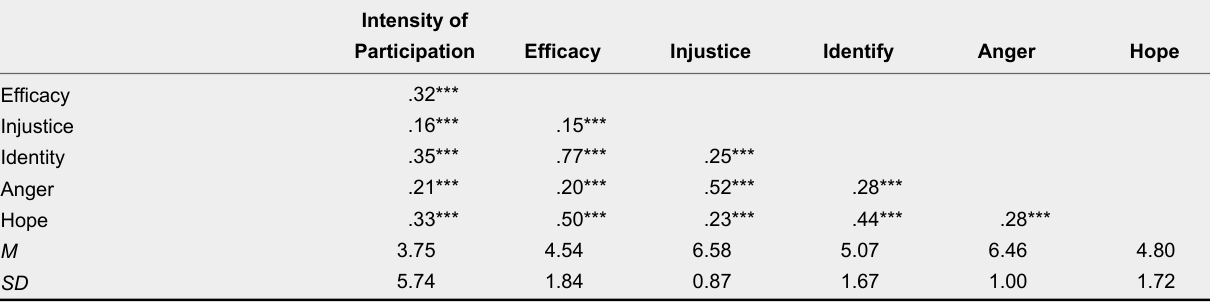
Correlations and Descriptive Statistics of the Variables Included in the Models